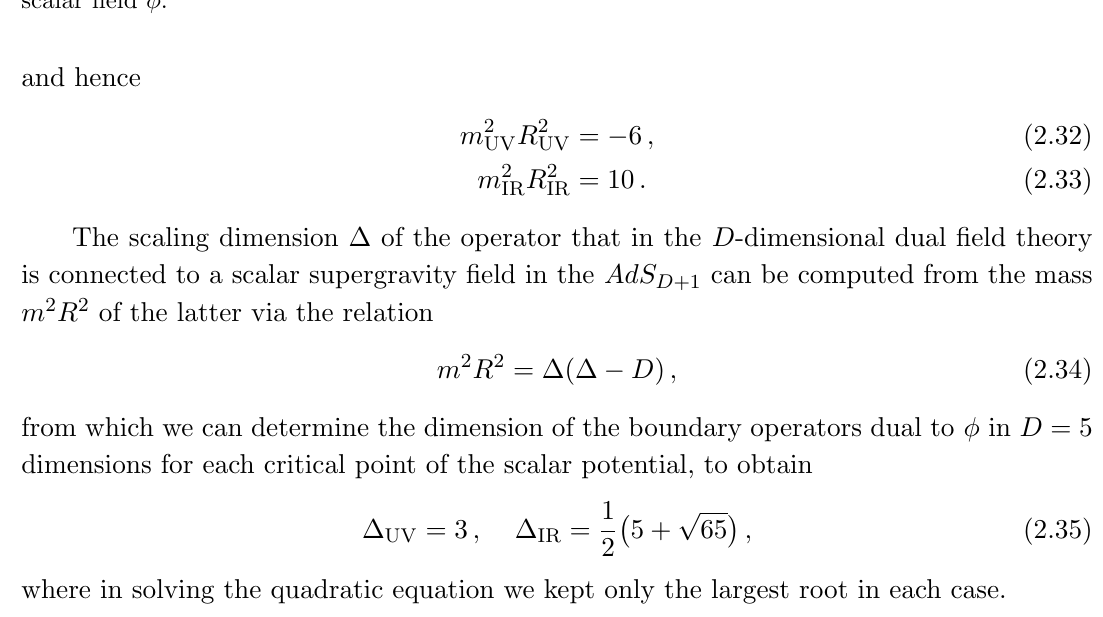
Figure 1 . The scalar potential scalar (cid:12)eld (cid:30)